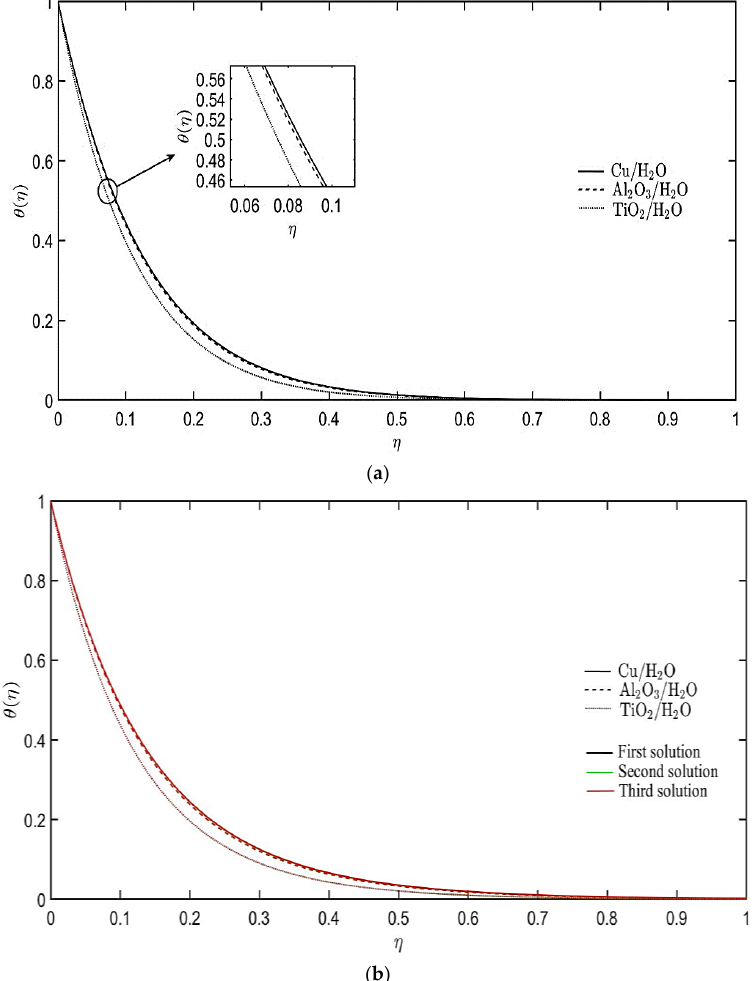
Figure 3. Temperature profiles of different nanofluids for: ( a ) Stretching case; ( b ) Shrinking case.